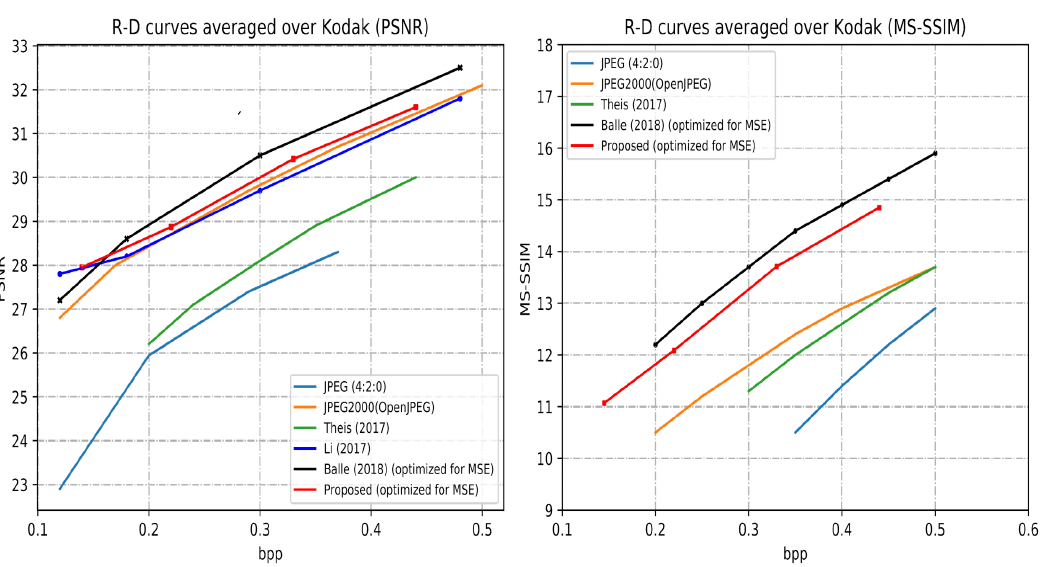
Figure 5. Rate–distortion curves of the proposed method and competitive approaches over the Kodak dataset. The measures are the PSNR and the MS-SSIM value as a function of BPP. Note that the PSNR’s formula is 10 × log 10 255 2 , and MS-SSIM values are converted into decibels for better visualization MSE ( − 10 × log 10 ( 1 − MSSSIM )